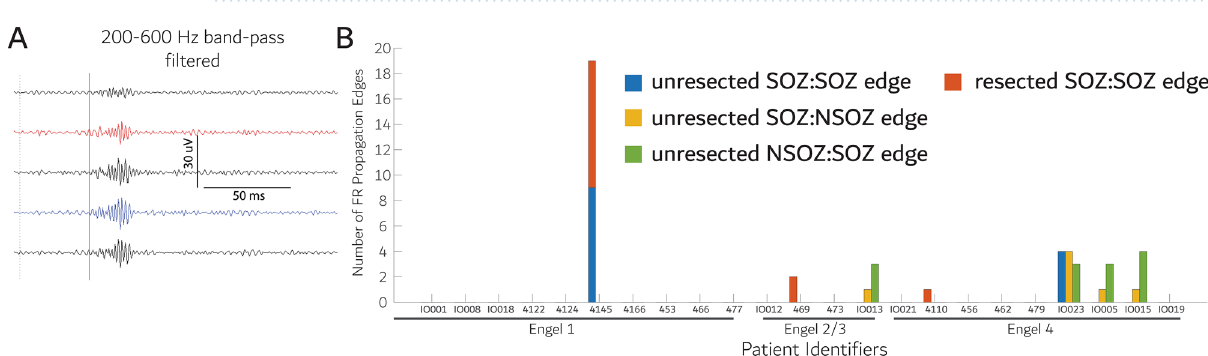
Figure 9. Resection of the electrode contacts where fast ripples (FR) on oscillations propagate from does not reliably correlate with post-operative seizure outcome. ( A ) an example of a fast ripple on oscillation propagation event from the intracranial EEG (iEEG) recorded from the contact in the blue trace to that from the contact in the red trace. All FR in the contact in red reliably followed those FR from the contact in blue (sign test, p < 0.005). ( B ) Stacked grouped bar graph of the correlation of outcome in individual patients with the number of contact pairs (i.e., edges) exhibiting FR propagation that were resected or left intact. Only a small minority of the patients exhibited FR propagation and complete resection of FR propagation sites did not correlate with seizure free outcome in any of the